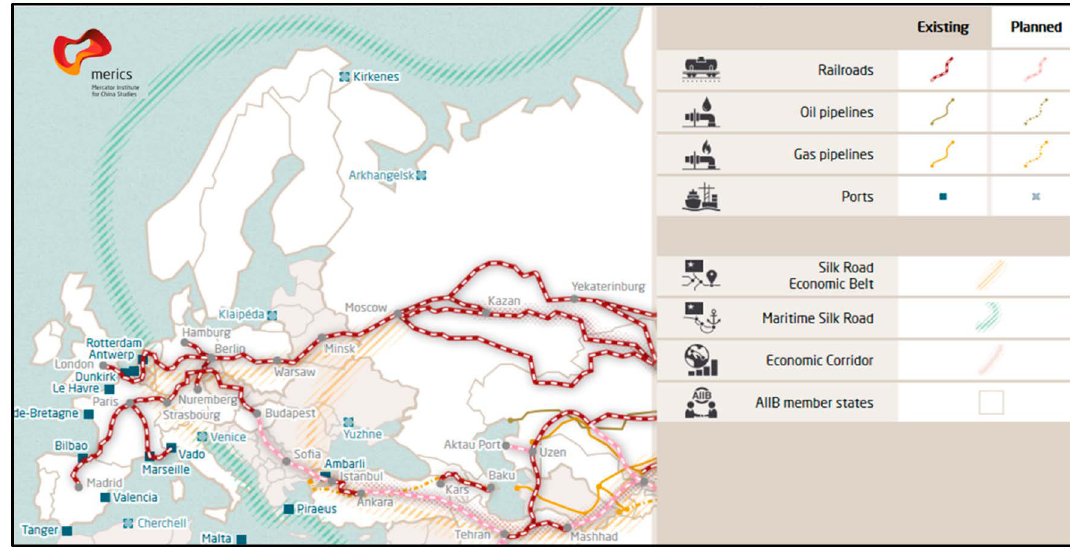
Figure 15 The BRI in Europe. Source: Mercator Institute for China Studies, ‘China Creates a Global Infrastructure Network’ (2018) <https://www.merics.org/en/bri-tracker/interactive-map>